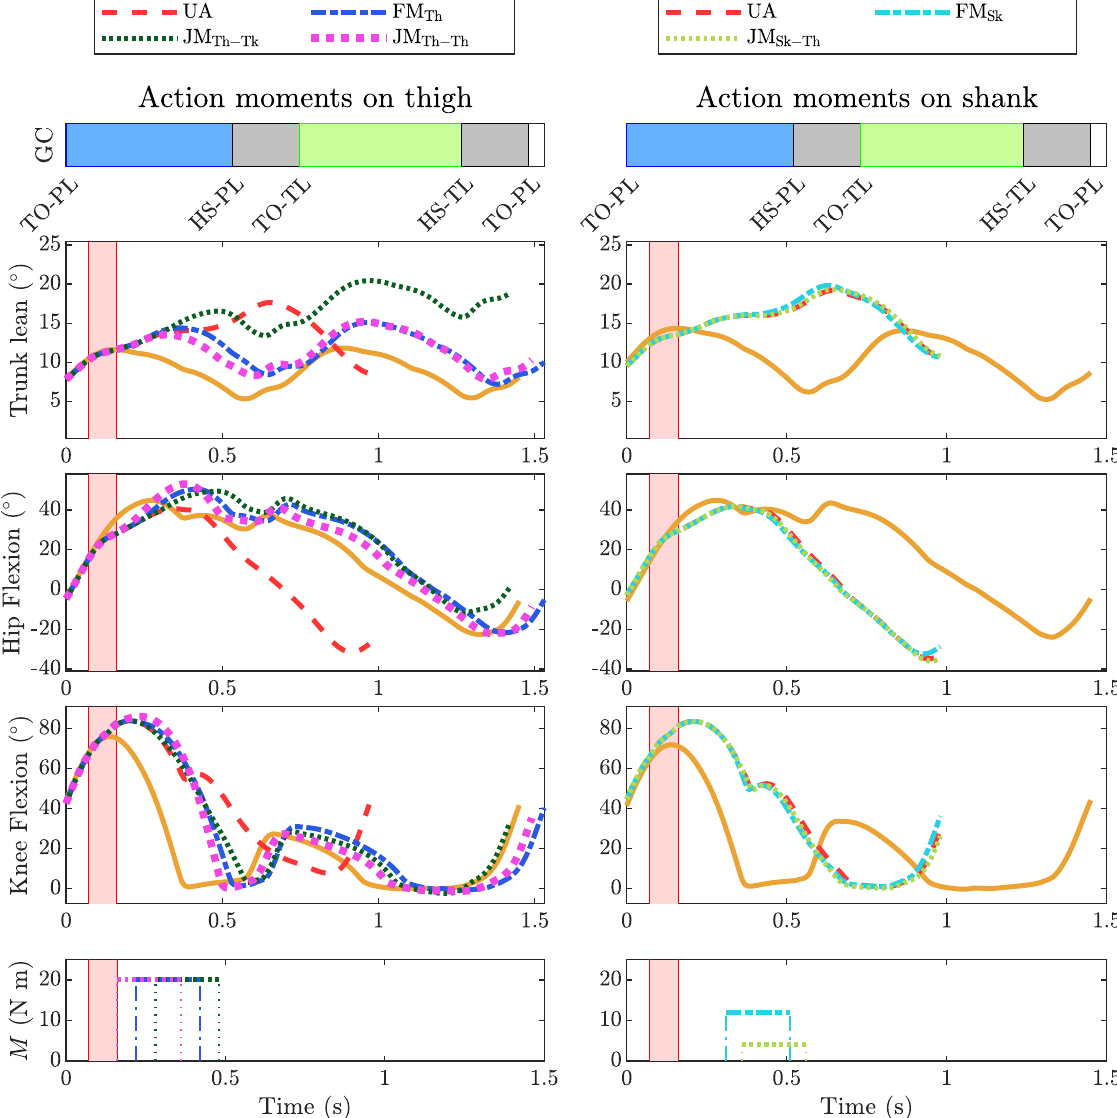
Fig 7. Kinematic response to perturbation P4. Left column: Assistance via hip flexion of the perturbed limb. Conditions denoted by lines are unperturbed (UP), unassisted (UA), free moment with action on thigh (FM Th ), joint moment with action on thigh and reaction on trunk (JM Th-Tk ), joint moment with action on thigh and reaction on contralateral thigh (JM Th-Th ). Right column: Assistance via knee extension of the perturbed limb. Conditions denoted by lines are unperturbed (UP), unassisted (UA), free moment with action on shank (FM Sk ), joint moment with action on shank and reaction on thigh (JM Sk-Th ). Individual plots show the trunk lean angle, hip flexion angle, and knee flexion angle, and applied moment M as a function of time. Bar graphs at top of each column show the gait events of the unperturbed gait cycle (GC), where TO-PL and HS-PL are toe-off and heel-strike events of the perturbed limb, and, TO-TL and HS-TL are toe-off and heel-strike events of the trailing limb.